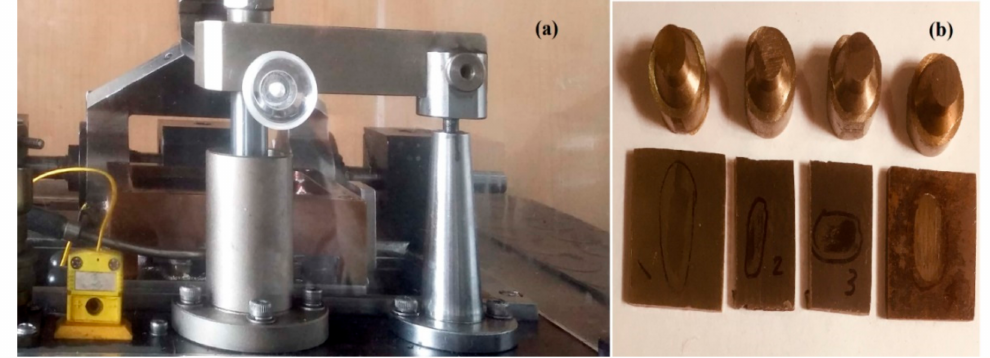
Figure 2. ( a ) Linear reciprocating tribometer chamber ( b ) CrN-coated samples and counter-body after the wear